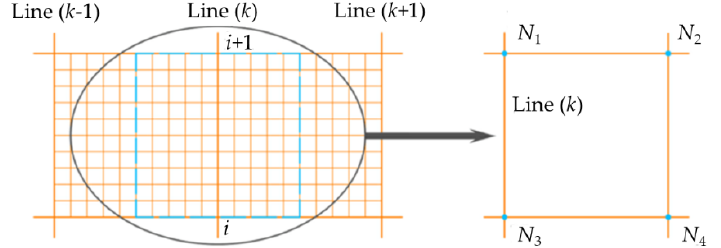
Figure 2. The equivalent model of the net.